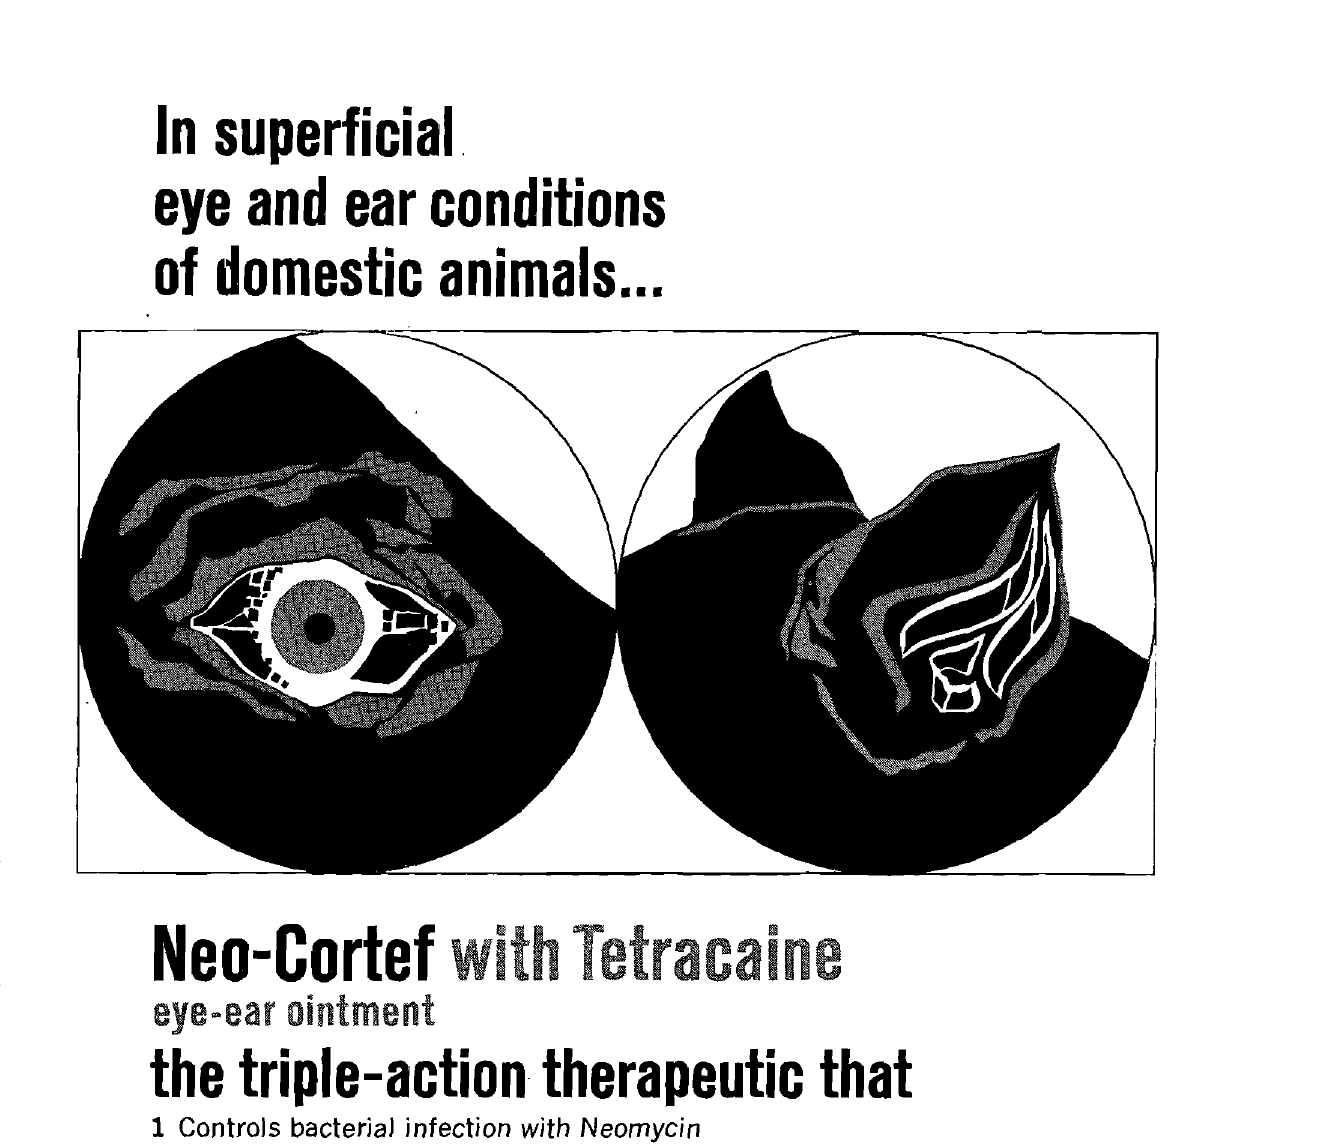
the triple-action therapeutic that 1 Controls bacterial infection with Neomycin 2 Suppresses inflammation with